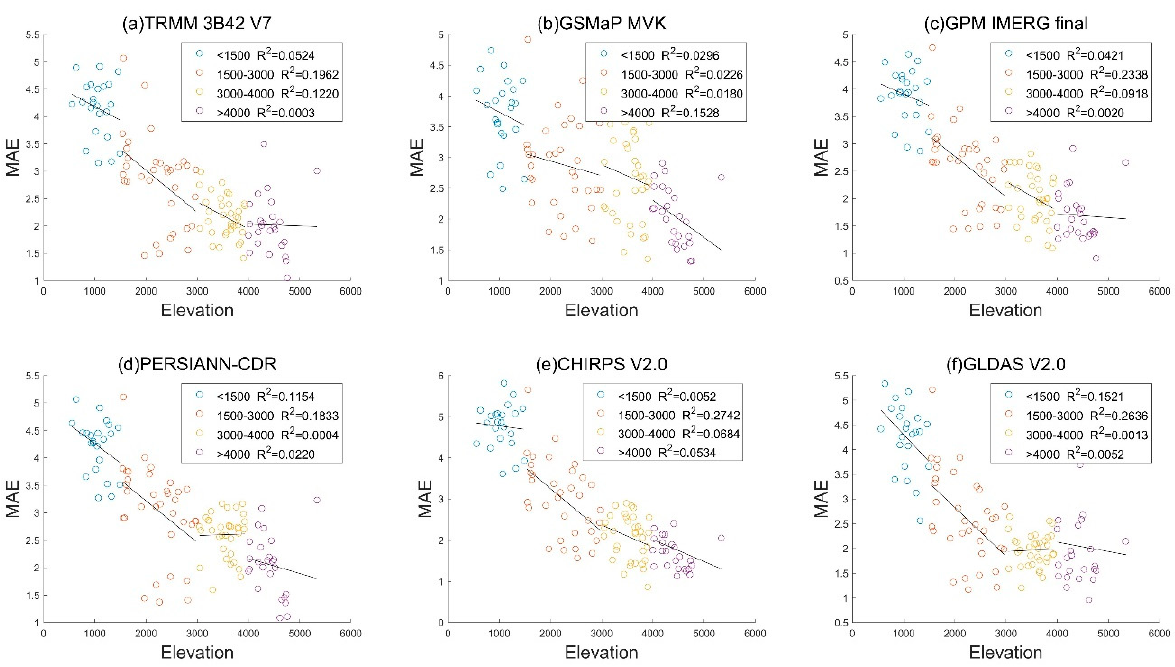
Figure 14. Linear relationship between MAE and elevation. ( a ) Represents the trend of MAE and Elevation for TRMM 3B42 V7 data products with elevation changes; ( b ) Represents the trend of MAE and Elevation for GSMaP MVK data products with elevation changes; ( c ) Represents the trend of MAE and Elevation for GPM IMERG final data products with elevation changes; ( d ) Represents the trend of MAE and Elevation for PERSIANN-CDR data products with elevation changes; ( e ) Represents the trend of MAE and Elevation for CHIRPS V2.0 data products with elevation changes; ( f ) Represents the trend of MAE and Elevation for GLDAS V2.0 data products with elevation changes;.